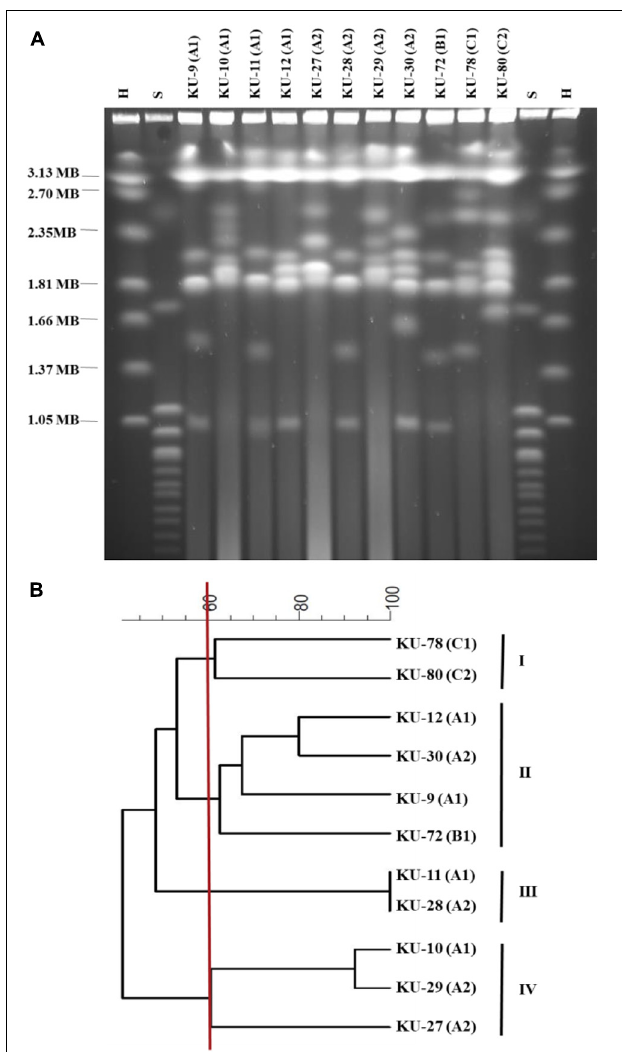
FIGURE 1 | (A) Chromosome polymorphism of D. hansenii strains isolated from Danish cheese brines. Pulsed-field gel electrophoresis (PFGE) was carried out at a 200 switch interval at 150 V for 24 h followed by a 700 s switch interval at 100 V for 48 h. Markers: H, Hansenula wingei ; S,